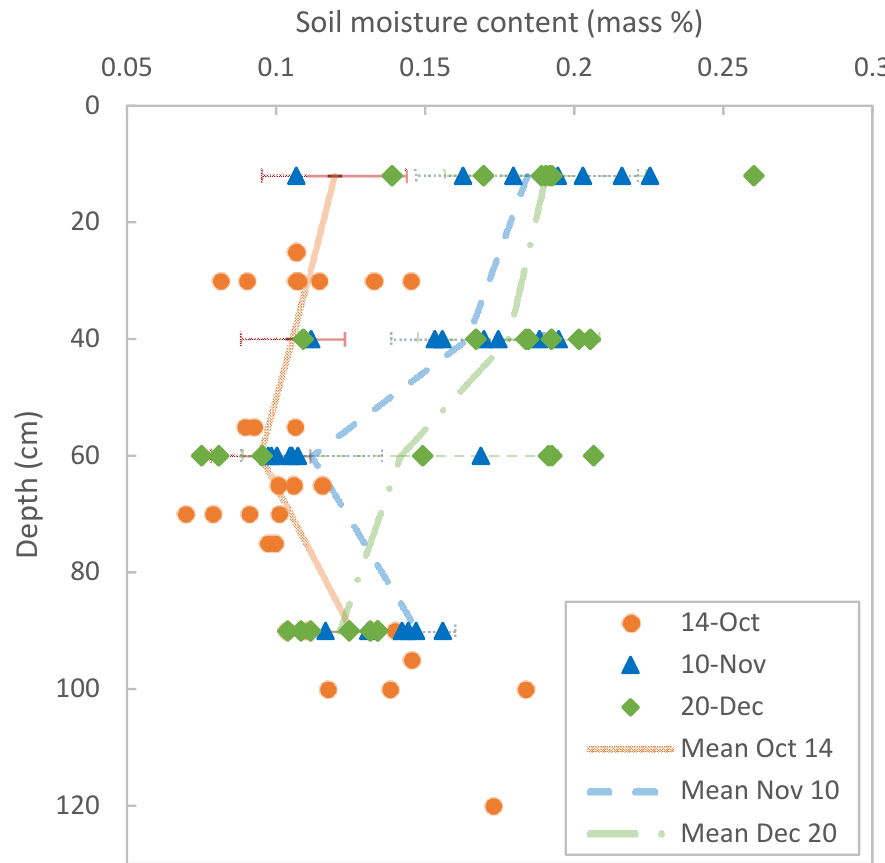
Figure 6. Soil-moisture measurements at the three dates, represented by circles, triangles, and diamonds. The lines represent the average soil moisture of the whole transect at that date. Average values for 14 October have been inter- and extrapolated for the sake of comparison with the other average values. The error bars represent the standard deviation of all measurements.